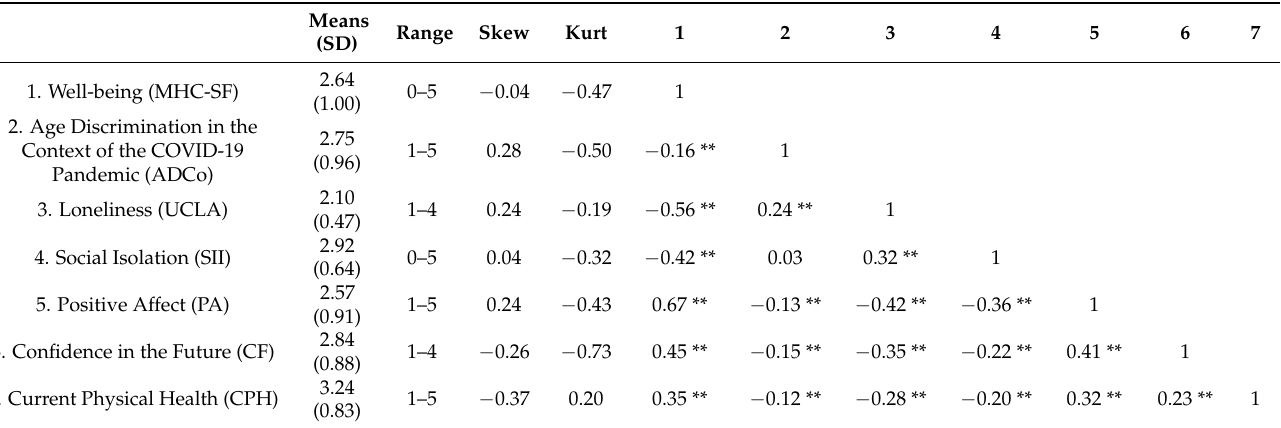
Table 1. Means, standard deviations, skewness, kurtosis, and correlations between the variables included in the